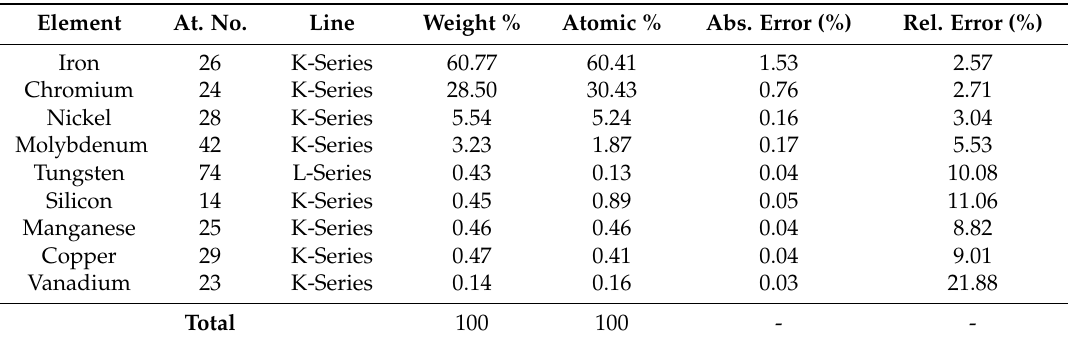
Table 3. The average chemical composition of austenite ( γ -Fe phase) found in the structure of UNS S32750 steel in the initial state. Element At. No. Line Weight %